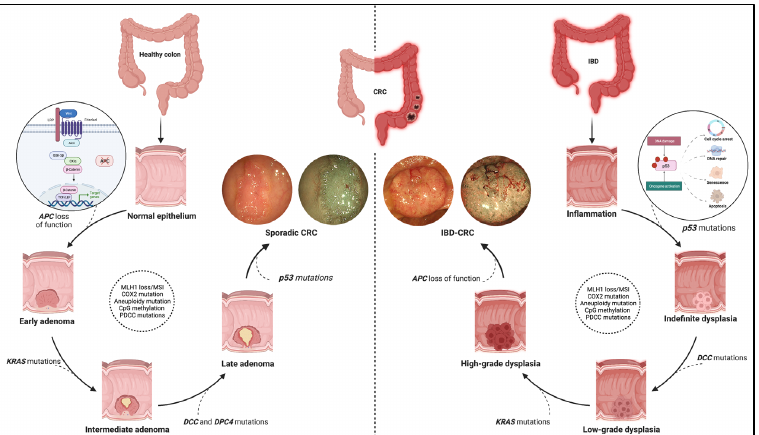
Figure 1. Pathogenic pathway of sporadic colorectal cancer and IBD-related colorectal cancer. The figure shows the different molecular pathways related to sporadic and IBD-related colorectal cancer (CRC). The sporadic CRC prevails in the adenoma-to-carcinoma sequence, while the inflammation– dysplasia–carcinoma cascade characterises the colitis related-CRC. In addition, the main gene